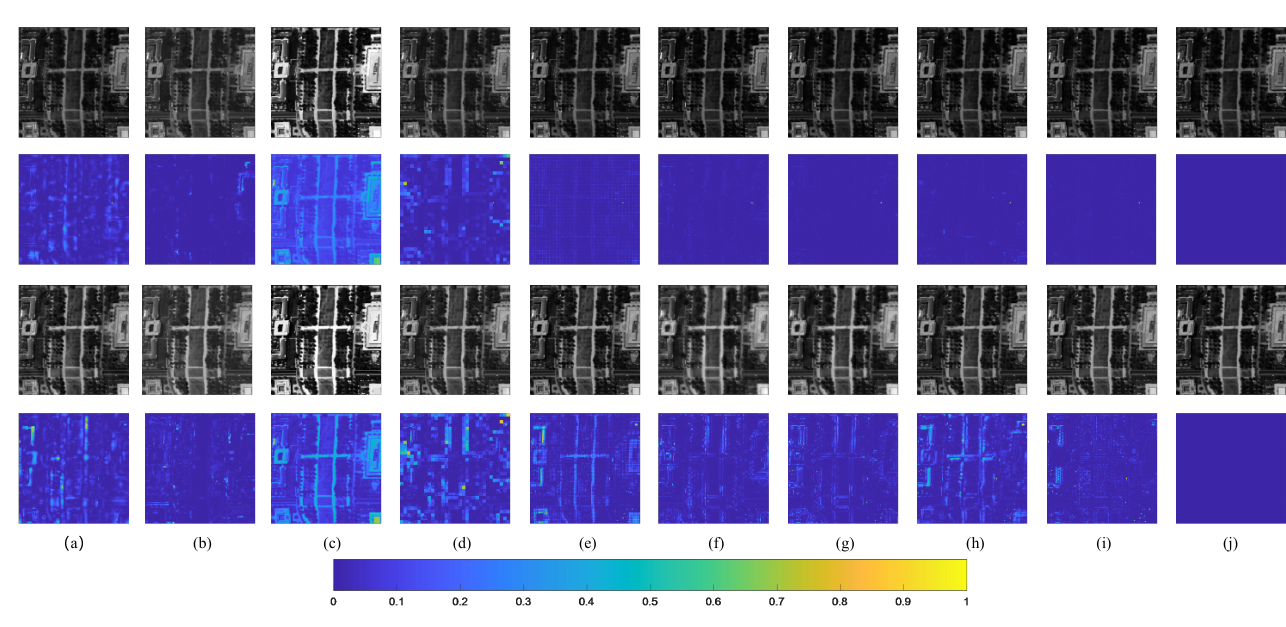
Figure 3. Reconstructed HR-HSI and corresponding error images for Washington DC Mall. First and second rows: reconstructed HSI and its corresponding error image at the 15th band. Third and fourth rows: reconstructed HSI and its corresponding error image at the 38th band. ( a ) GSA; ( b ) CNMF; ( c ) CSU; ( d ) NSSR; ( e ) LRSR; ( f ) LTTR; ( g ) FuVar; ( h ) LRTD; ( i ) HTSR; ( j ) Ground